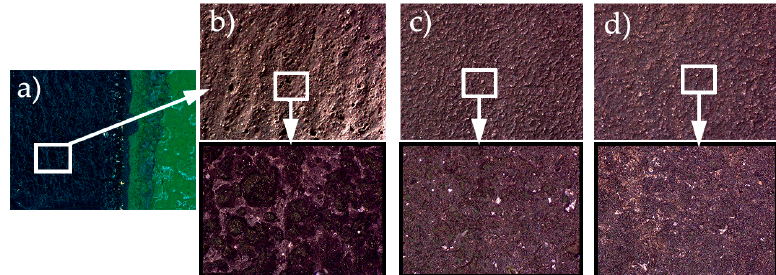
Figure 7. Surfaces after laser application: ( a ) magnifying glass test T6; ( b ) microscopy test T6, molten substrate; ( c ) microscopy test T8, clean substrate; ( d ) microscopy test T10, substrate with clear stains of coating rests.